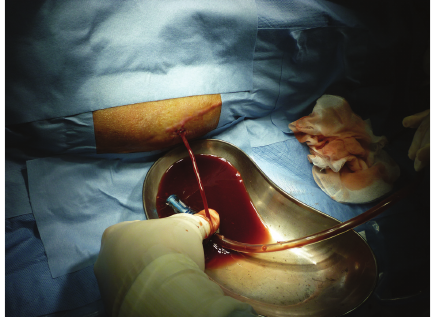
Figure 4: A physician at a rehabilitation hospital punctured the hematoma, releasing about 50mL of uncoagulated bloody liquid. Subsequently bloody liquid continued to flow from the puncture needle hole.